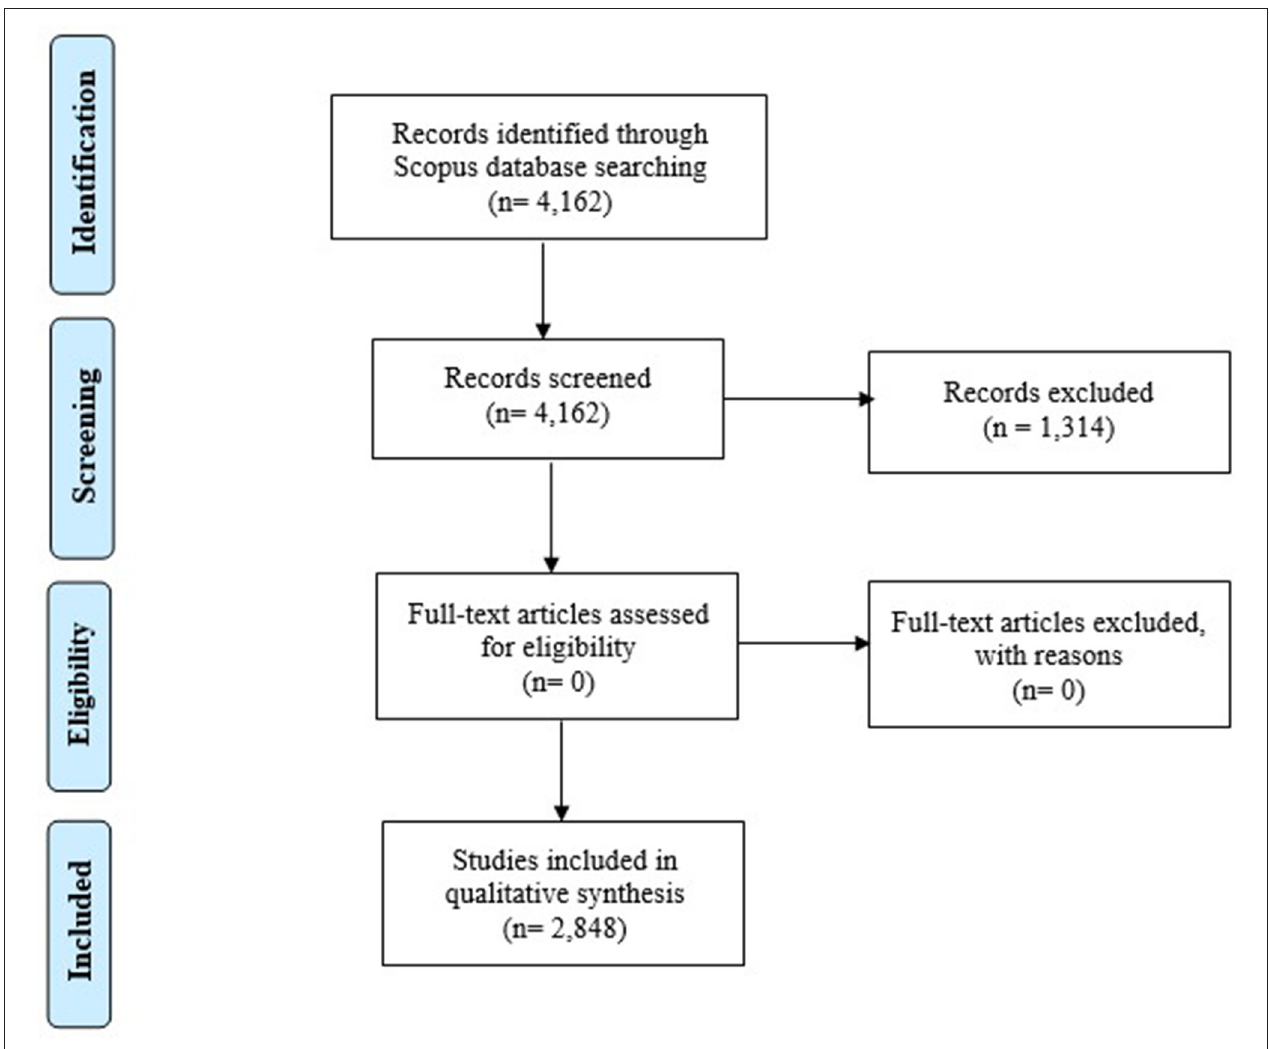
FIGURE 1 | Flow Diagram—PRISMA method,